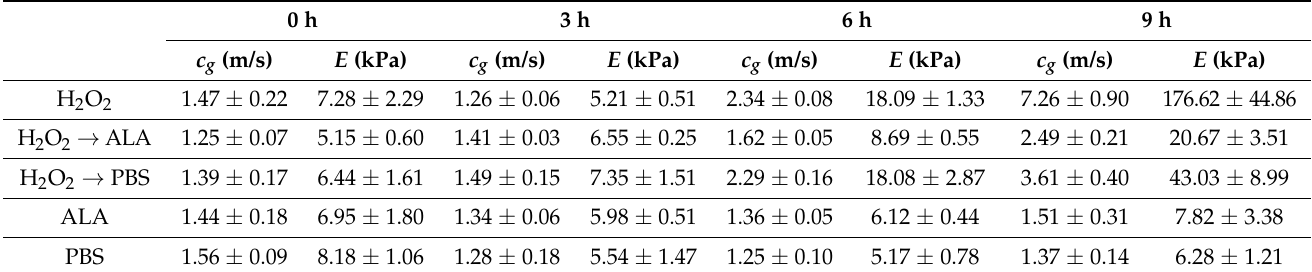
Table 1. Surface wave group velocities and Young’s moduli of the lenses incubated in different storage media. The error is the intersample standard